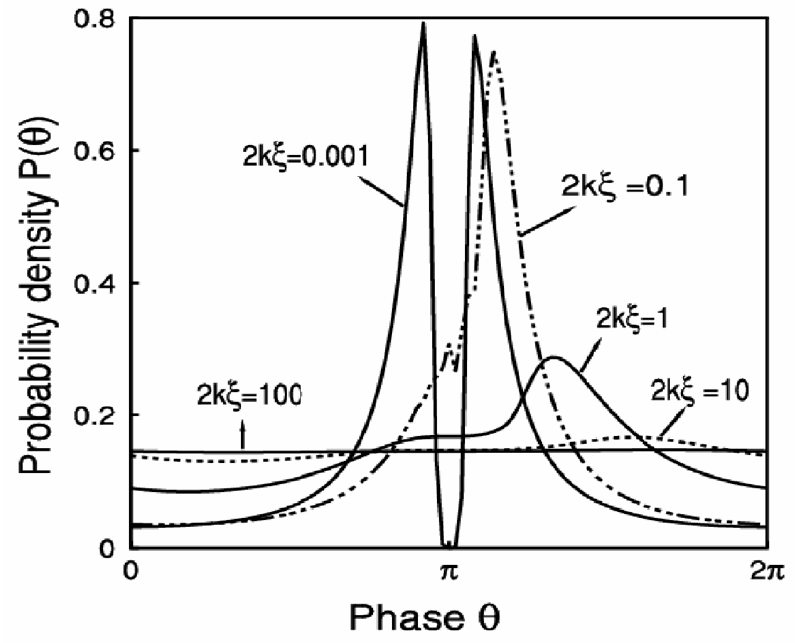
Figure 7. Phase θ distribution P ( θ ) against the disorder parameter 2 k ξ for the asymptotic limit of large length l = 10 (large).